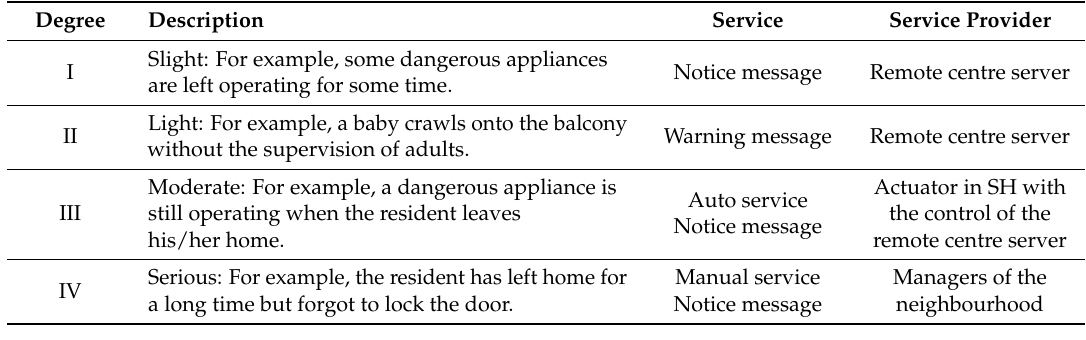
Table 5. Risk degree classification of different situations.